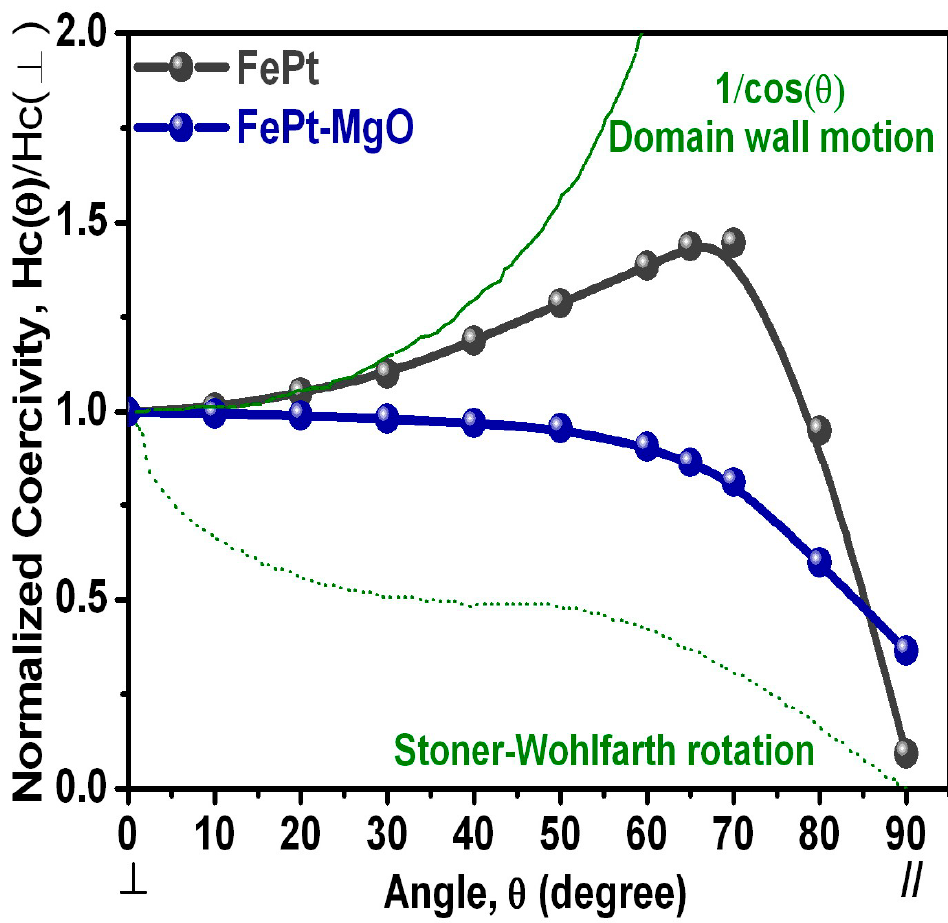
Figure 4. The curves for angular dependence of coercivity for the FePt films without and with MgO additive nanolayers, respectively. The angle refers to that between the easy axis (film normal) and the applied magnetic field direction.